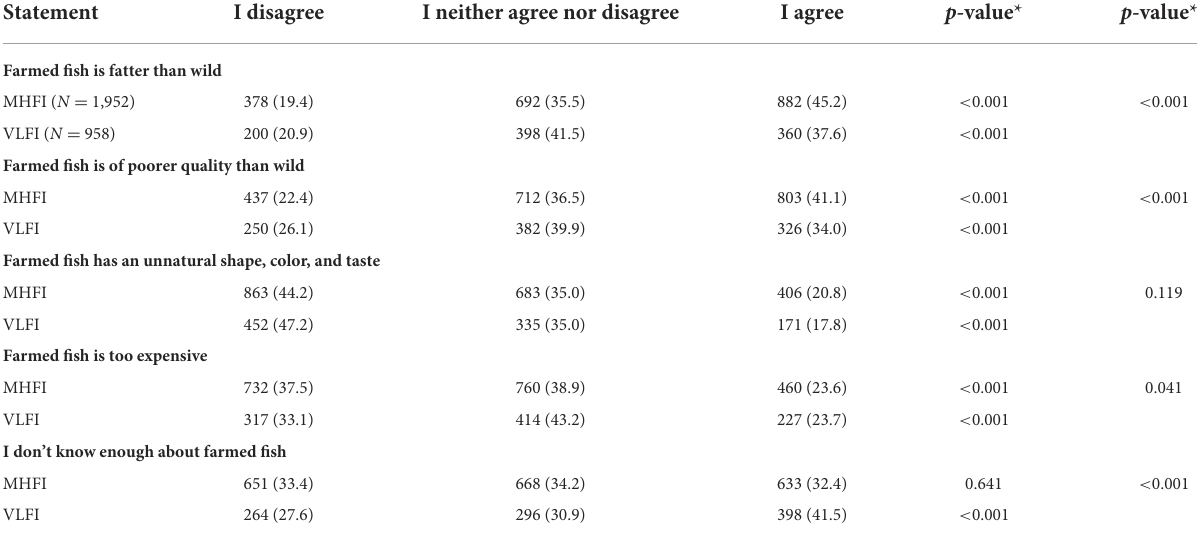
TABLE 5 Attitudes toward farmed fish and its quality ( N = 2,910) among groups according to recommended fish